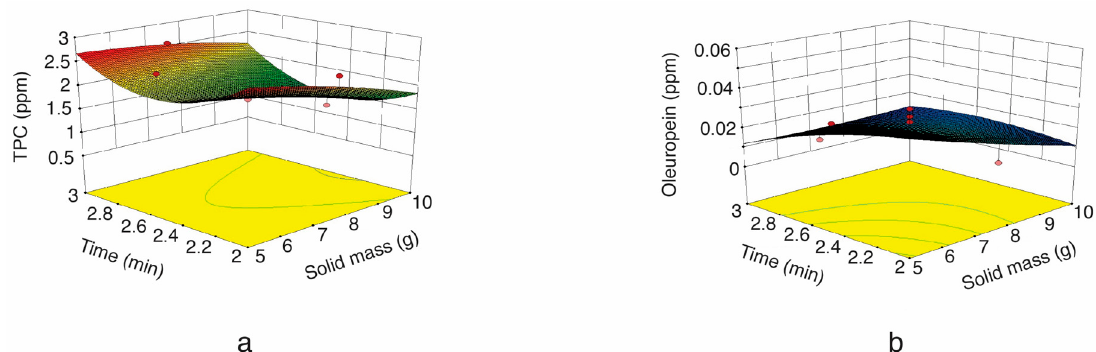
Figure 2. Response surface plot for the TPC ( a ) and oleuropein ( b ) from olive leaf extract as a function of extraction time to solid mass (microwave irradiation power = 300 W).